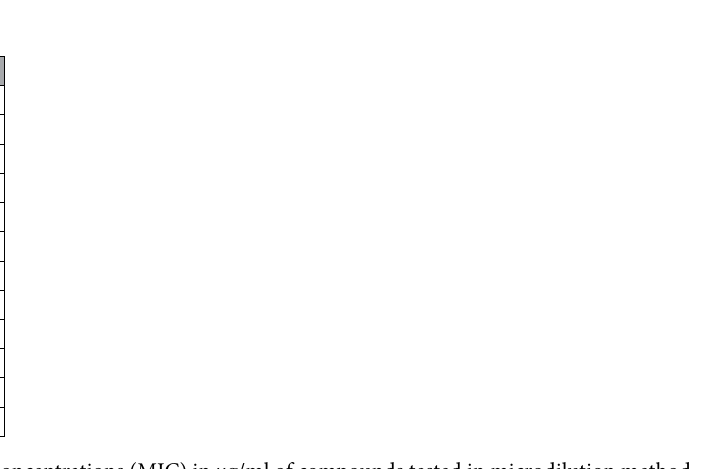
Table 4. Minimum inhibitory concentrations (MIC) in µg/ml of compounds tested in microdilution